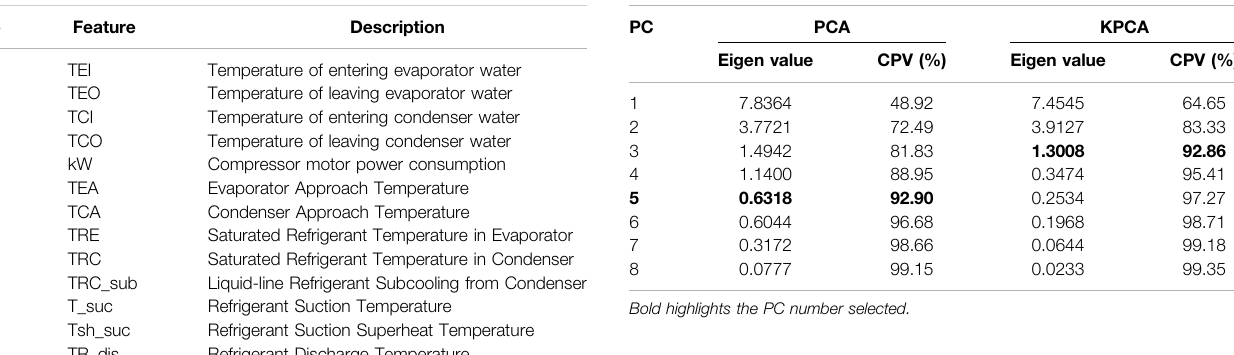
TABLE 2 | Descriptions of the selected features. TABLE 3 | Data decomposition results based on PCA and